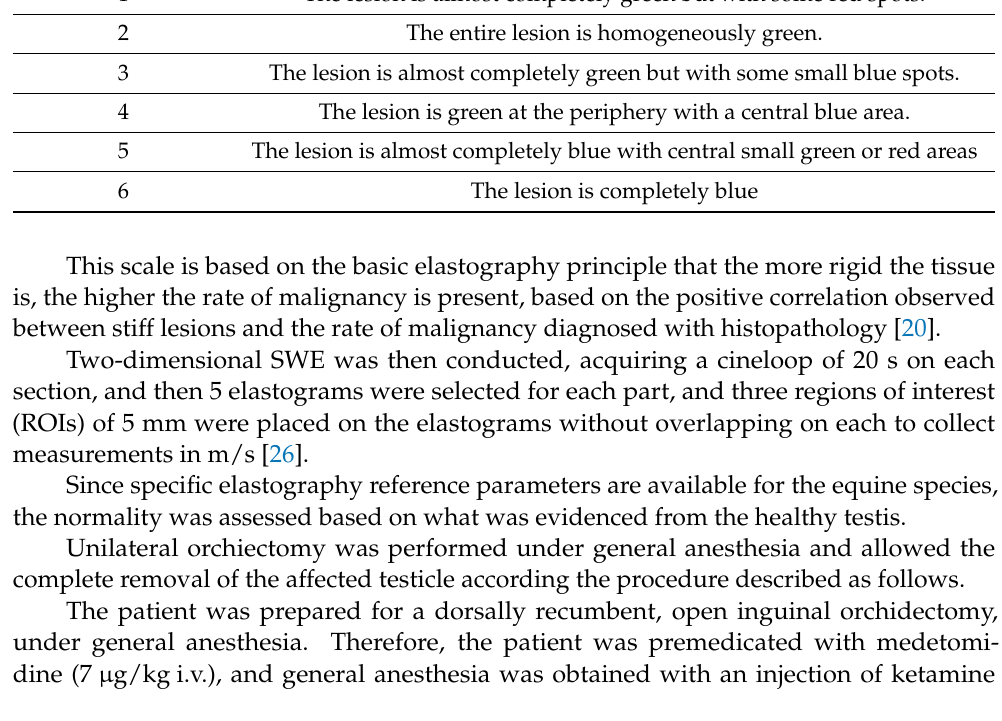
Table 1. SE elastographic color coded scale classification. Grading